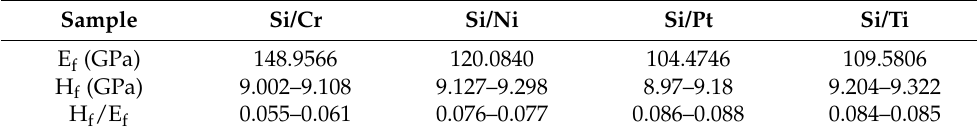
Table 1. Analytical solution for thin-film elastic modulus and